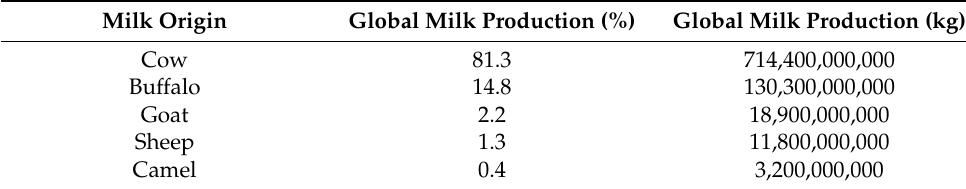
Table 1. Mean contribution of individual species’ milks towards global production [24]. Milk Origin Global Milk Production (%) Global Milk Production (kg) Cow 81.3 Buffalo 14.8 Goat 2.2 Sheep